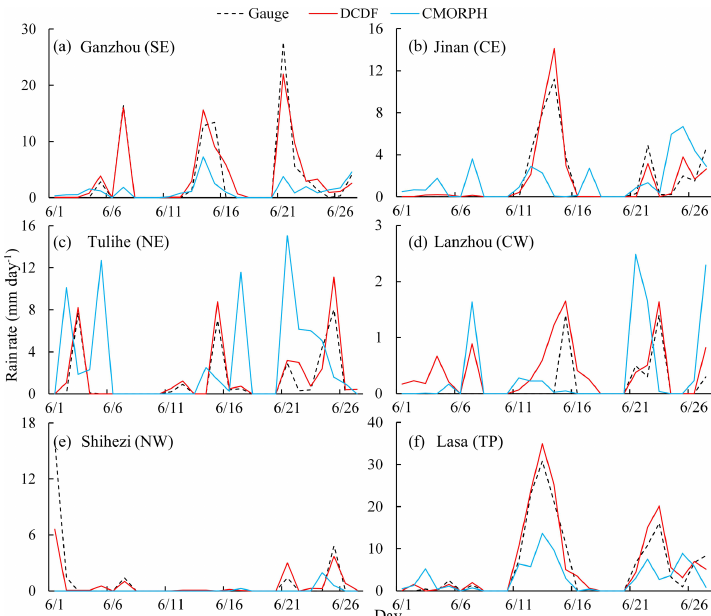
Figure 8. Time series of rain gauge data, original CMORPH and DCDF precipitation for each randomly selected gauge. (a) Ganzhou station (SE): 113.1667 ◦ E, 25.8667 ◦ N. (b) Jinan station (CE): 117.05 ◦ E, 36.6 ◦ N. (c) Tulihe station (NE): 121.6833 ◦ E, 50.4833 ◦ N. (d) Lanzhou station (CW): 103.8833 ◦ E, 36.05 ◦ N. (e) Shihezi station (NW): 86.05 ◦ E, 44.3167 ◦ N. (f) Lasa station (TP): 91.1333 ◦ E, 29.6667 ◦